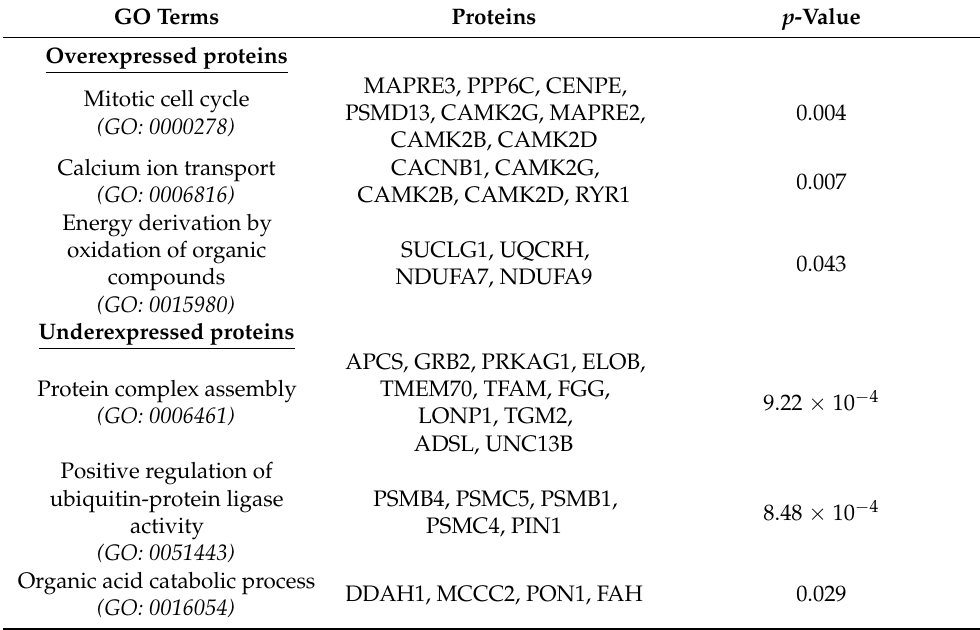
Table 4. Biological processes according to the results of the DAVID functional enrichment analysis of over- and underexpressed proteins in the VPG vs. CG.